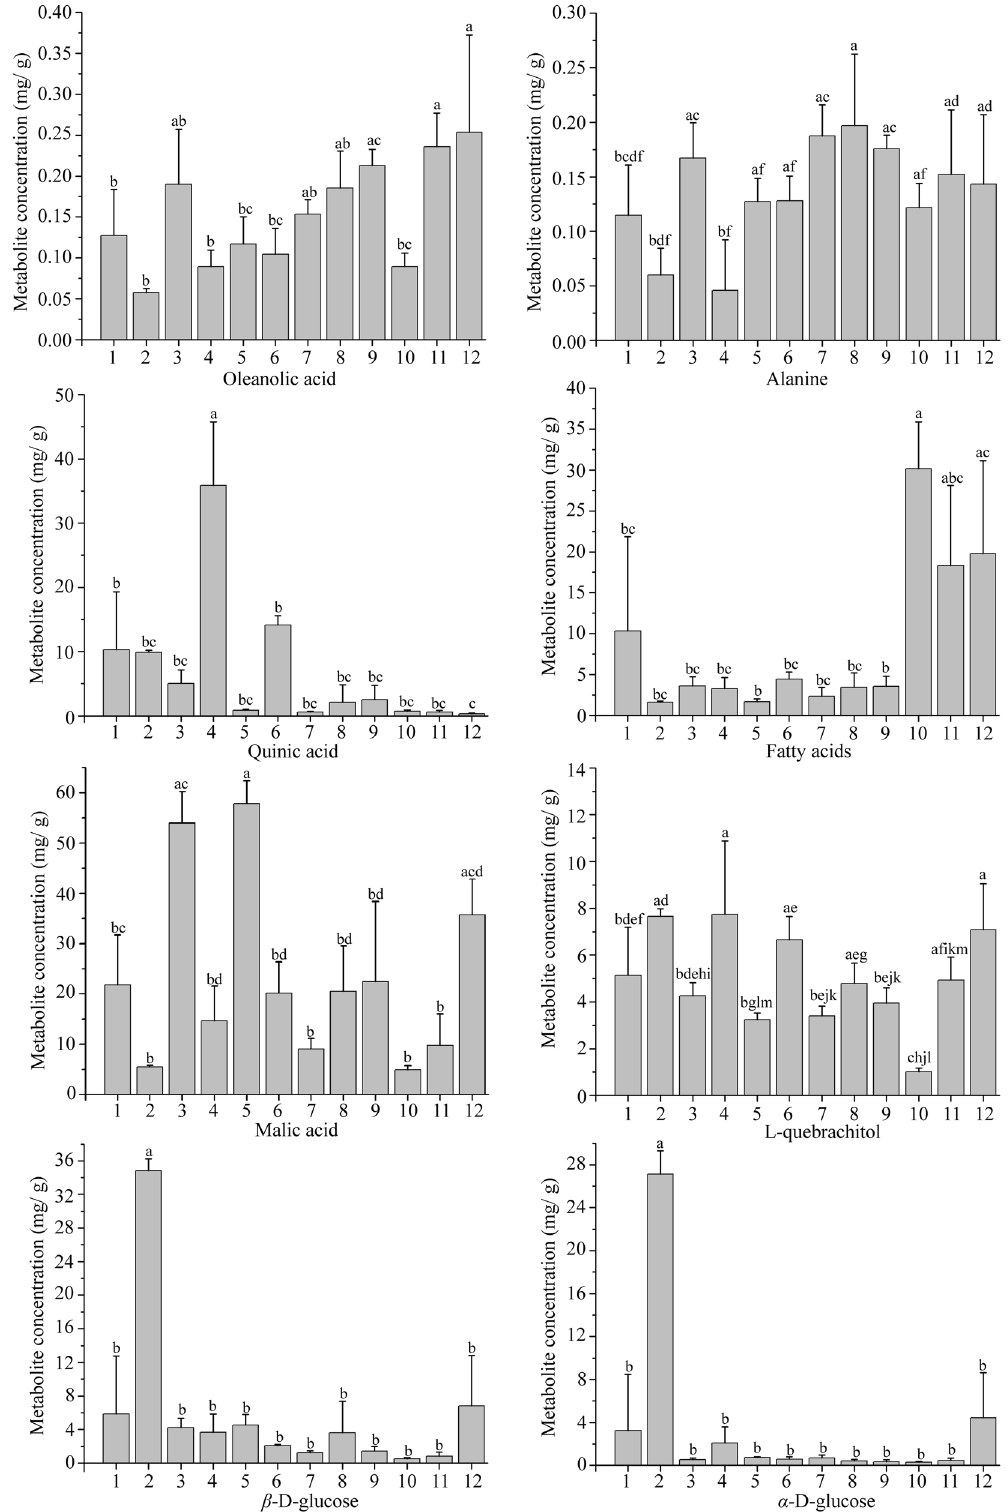
Figure 4. 1 H NMR intensities of eight metabolites in sea buckthorn berries from seven species and seven subspecies of Hippophaë . (1) H . rhamnoides ssp. sinensis , (2) H . rhamnoides ssp. mongolica , (3) H . rhamnoides ssp. yunnanensis , (4) H . rhamnoides ssp. turkestanica , (5) H . rhamnoides ssp. wolongensis , (6) H . goniocarpa , (7) H . litangensis , (8) H . neurocarpa ssp. neurocarpa , (9) H . neurocarpa ssp. stellatopilosa , (10) H . salicifolia , (11) H . gyantsensis , and (12) H . tibetana . Data are given as mean ± SD. Different letters above the bars indicate significant differences between species, and the same letters above the bars indicate no significant differences between species based on Tukey’s multiple comparison tests ( p <